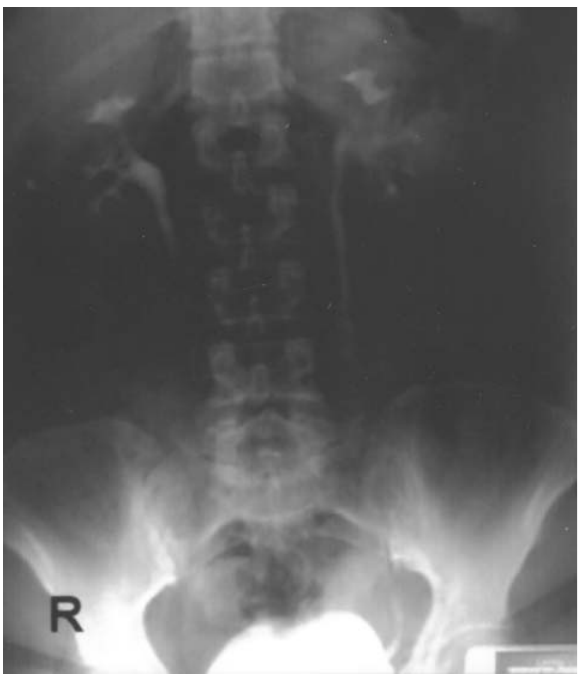
Figure 7 – IVP of the patient with distal ureteral obstruction and ureterovaginal fistula, performed 1 year postoperatively revealed normal left distal ureter and resolution of the